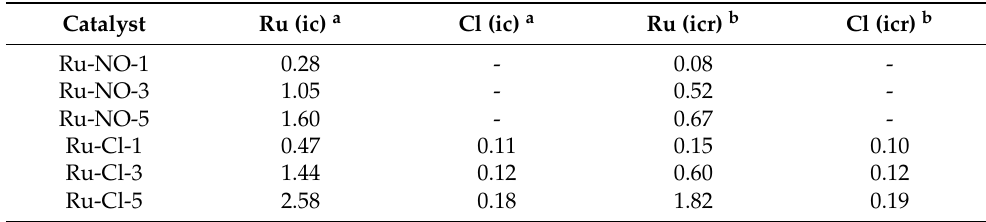
Table 2. XRF data for all ruthenium on γ -Al 2 O 3 catalysts after calcination and reduction. (a) Impregnated-calcined; (b) impregnated-calcined-reduced (reduction: dynamic flow @ 450 ◦ C